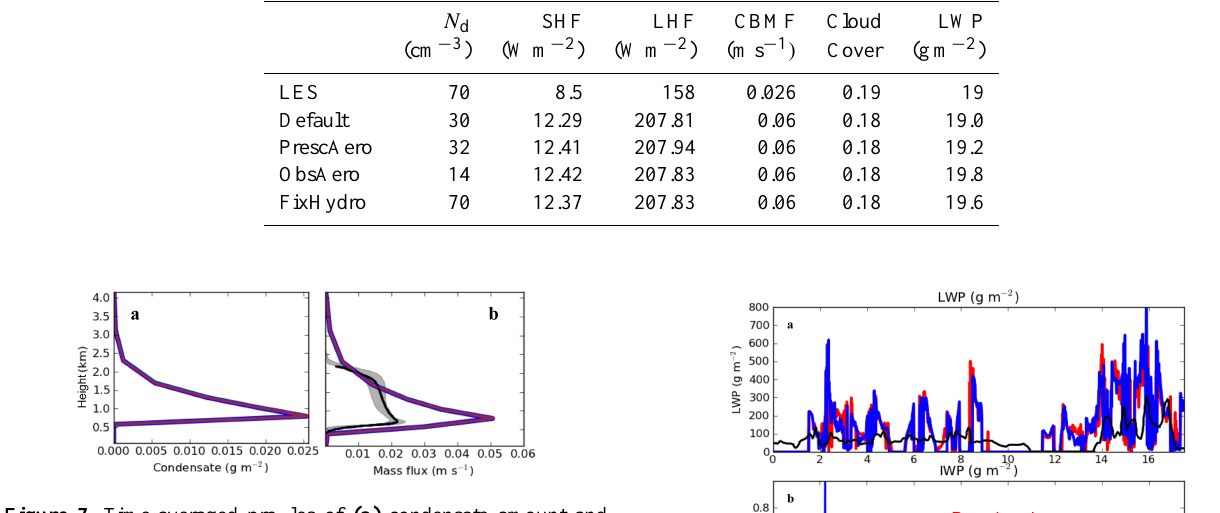
Figure 7. Time-averaged profiles of (a) condensate amount and (b) mass flux for RICO simulations. The colored line shows the SCM results (all simulations lie on top of one another). Shading in figure 8b indicates ensemble inter quartile range and the solid black line is the ensemble mean. LES data are from VZ11.